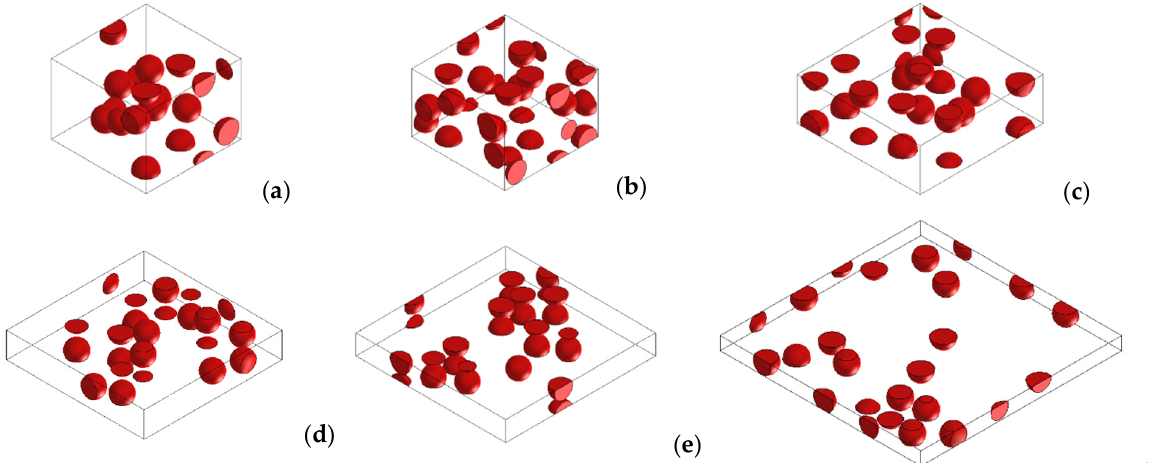
Figure 4. A meshed RVE for 9.5 vol.% Cu and 45 μ m thickness for the Cu-PU film composite. The red dots are the Cu particles and dark blue is PU matrix 3. Results and Discussion 3.1. Characterization and Electrical Conductivity Figure 5 shows the SEM images of the Cu particles in as-received condition. The gen- eral image (Figure 5a) shows that the size and morphology of the particles was very sim- ilar and thus confirms the homogeneity of the powder. To characterize the particles in more detail, a magnified image is shown in Figure 5b. It was observed that the size of the particles ranged from about 5 to 25 μ m and most of them were not perfectly round but exhibited some irregularities such as spiky particles with sharp protrusions. Figure 6 shows particle size distribution of Cu powder, obtained by using ImageJ software. As it is shown in Figure 6, the particle size was in the range of 5–23 μ m, mainly, and the mean size was about 12 μ m.